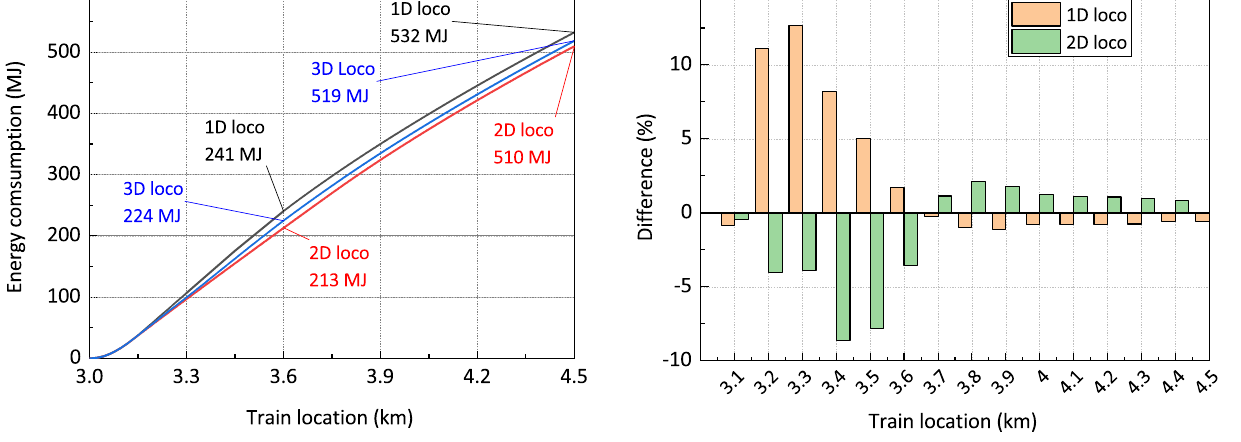
Fig. 8 Simulated energy consumptions of the leading locomotive Fig. 9 Differences of simulated energy Fig. 7. The coefficient of friction utilised by the locomo-